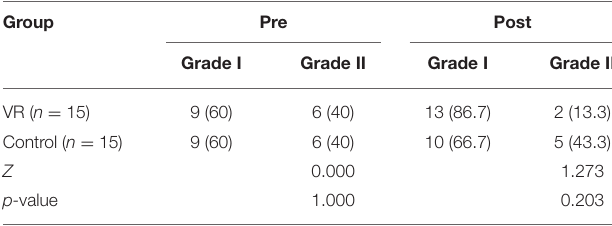
TABLE 4 | The grade of amplitude integrated electroencephalogram (aEEG) in two groups before and after treatment ( n ; %). Group